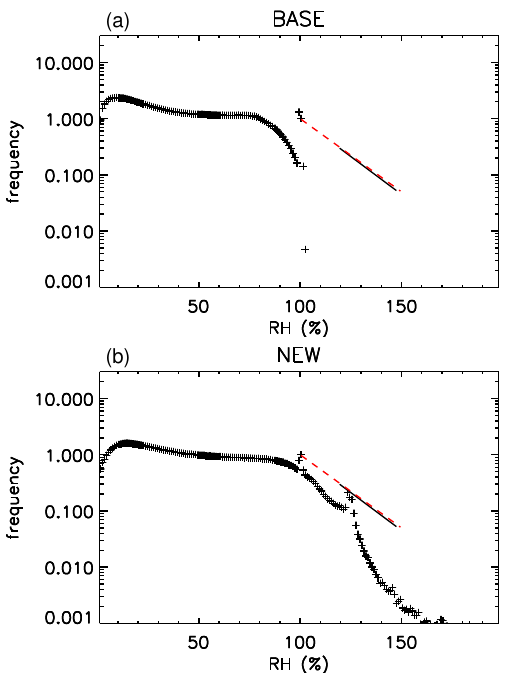
Fig. 5. Normalized (to RH = 100%) PDF of relative humidity with respect to ice outside clouds at the two model layers above and be- low 250hPa (crosses) and fits to climatological data from AIRS (red dashed line) (Gettelman et al., 2006) and to climatological data from MOZAIC observations (black solid line) (Gierens et al., 1999).